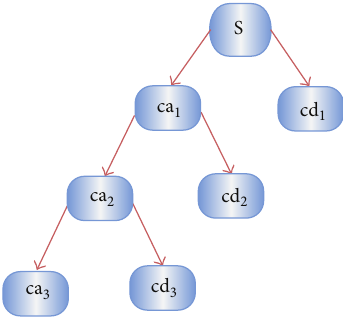
Figure 2: A 3-level wavelet decomposition tree.